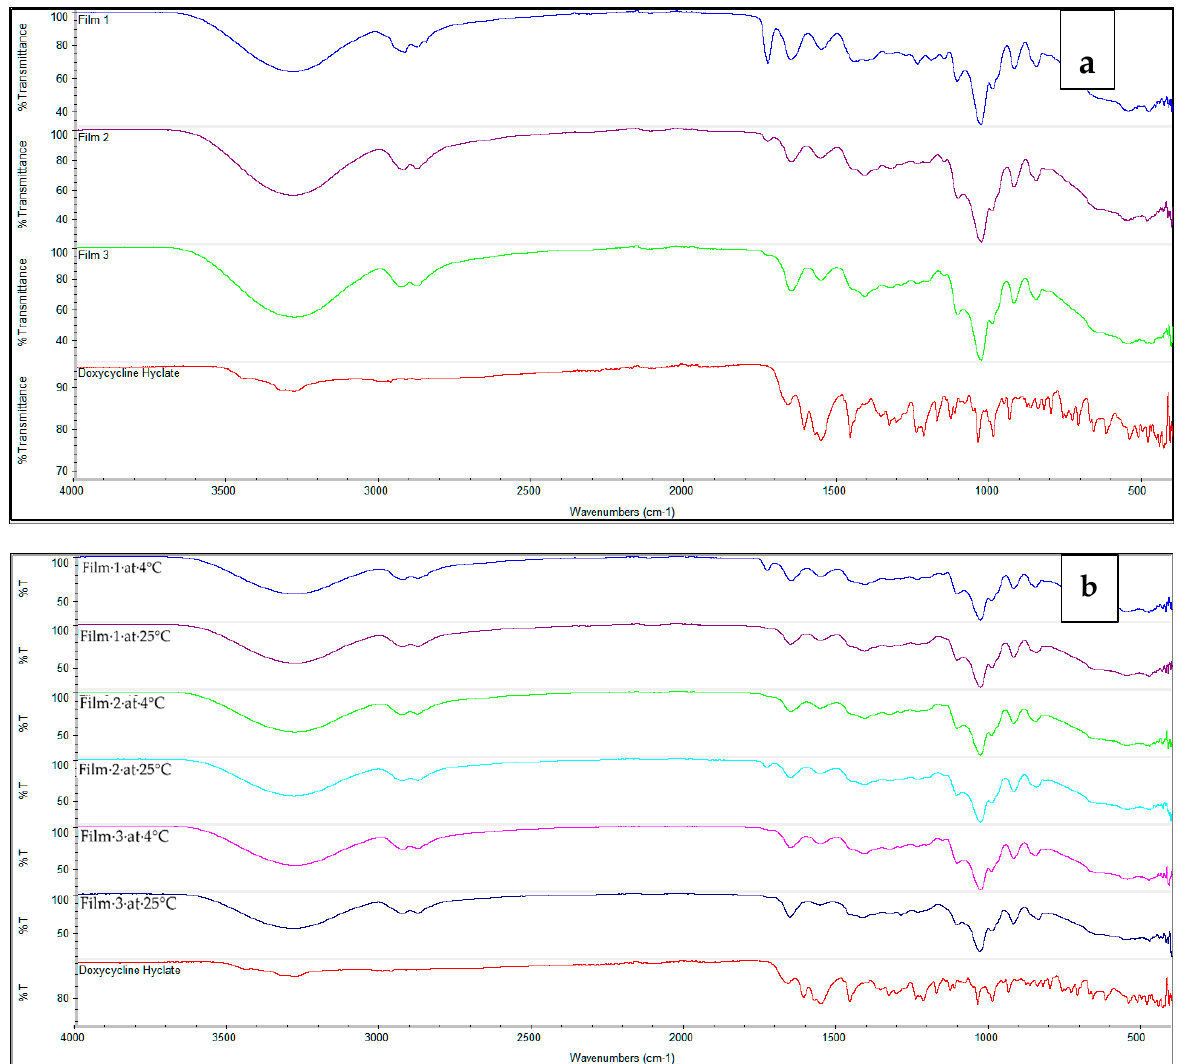
Figure 4. Fourier-transform infrared spectroscopy (FTIR) analysis of: pure doxycycline hyclate and in films at time zero ( a ) (top figure) and after 26-week storage at 4 °C and 25 °C ( b ) (bottom figure); Film 1 = contained doxycycline in chitosan, gelatin, povidone, glycerin and Eudragit ® RS 12.5; Film 2 = contained doxycycline, β -cyclodextrin and HPMC microparticles in chitosan, gelatin, povidone, glycerin and Eudragit ® RS 12.5; and Film 3 = same as in Film 2, but the manufacturing of microparticles was performed using sodium thiosulfate, MgCl 2 in 2% HPMC with Eudragit ® RS 12.5.